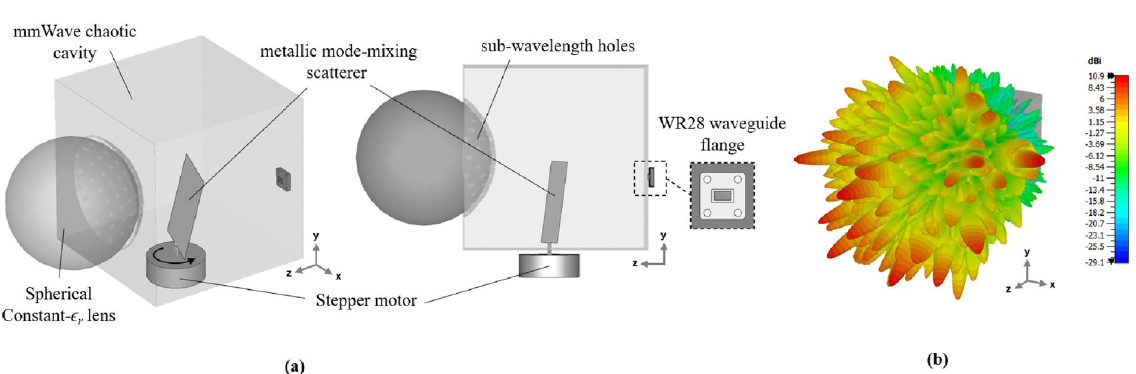
Figure 1. Operational block diagram of a state-diverse mode lens-loaded cavity aperture.